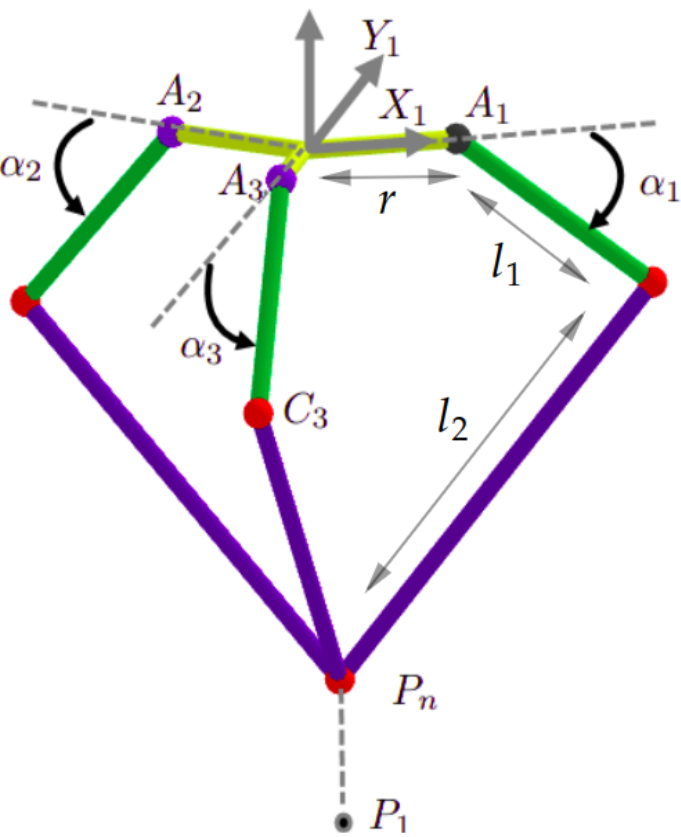
Figure 9. The simplification of the delta part, with r = l 0 − l 3 .